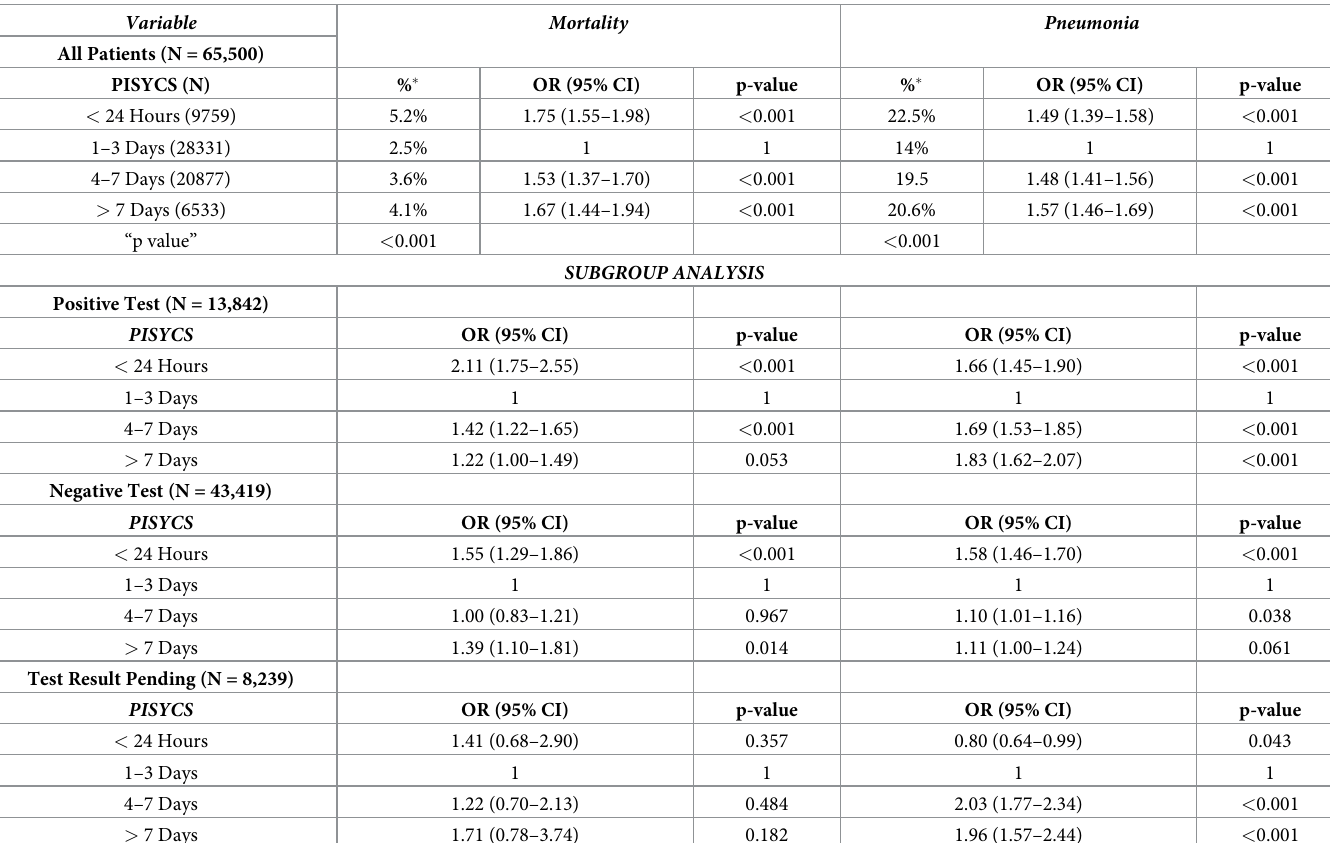
Table 3. Mortality and pneumonia among patients with COVID-19 according to the period between initial symptoms and clinical progression to COVID-19 suspi- cion (PISYCS).